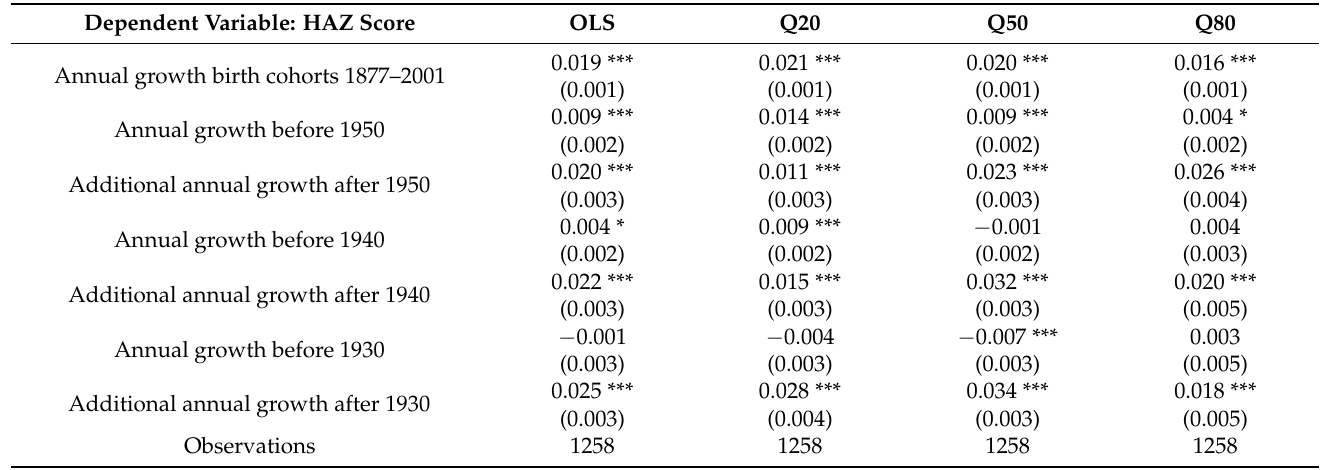
Table 6. Annual HAZ scores growth from OLS and quantile spline